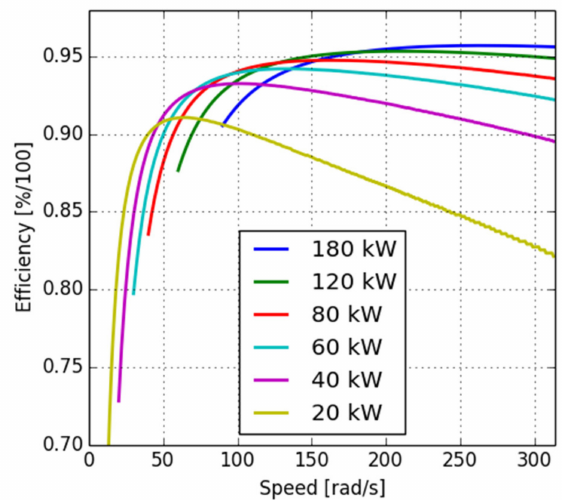
Figure 5. Combined e ffi ciency of the motor and the inverter at di ff erent power